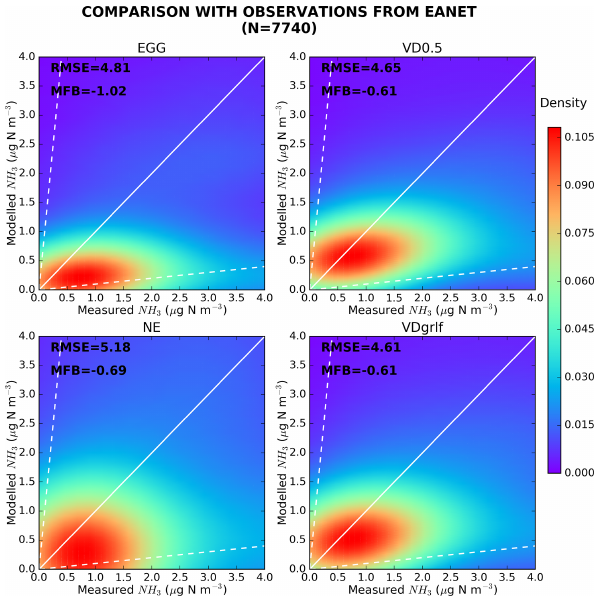
Figure 7. Validation of modelled concentrations of ammonia for different emissions datasets (EGG, VD0.5, NE and VDgrlf) against ground-based measurements from EANET for the 10-year (2008– 2017) study period. Scatterplots of modelled against measured con- centrations for the aforementioned emission inventories were plot- ted with the Kernel density estimation, which is a way to estimate the probability density function (PDF) of a random variable in a non-parametric way.